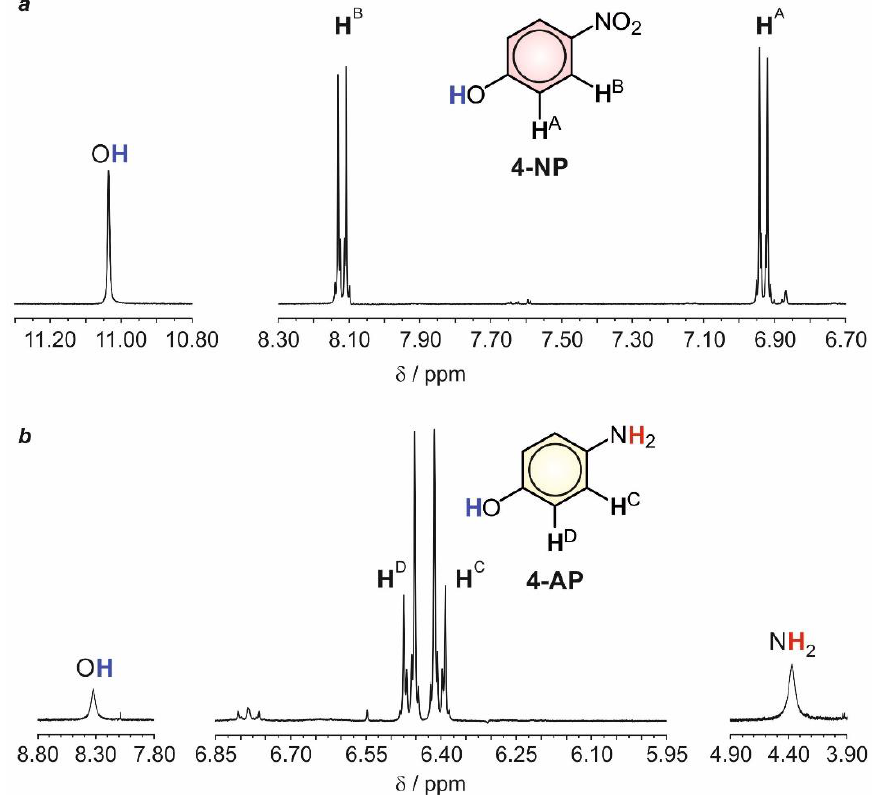
Figure 4. 1 H NMR spectra, recorded in d 6 -DMSO, of the remaining 4-NP ( a ) and the electro-generated 4-AP ( b ) in the electrolytic bath.